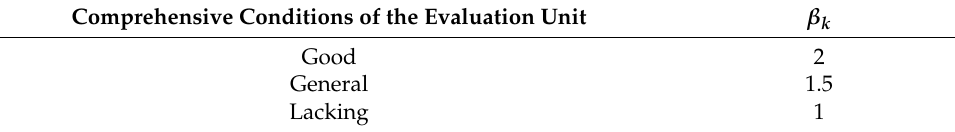
Table A2. Table of value range of β k .